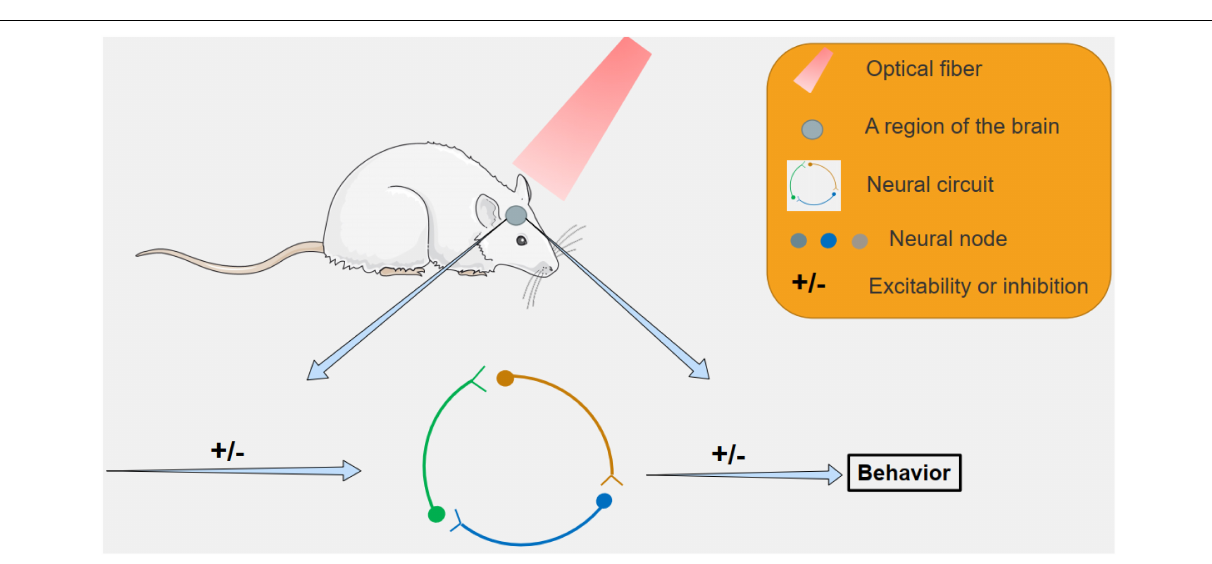
FIGURE 2 | The study of neural circuits by optogenetic methods. By targeting specific areas with light, specific neural circuits can be inhibited or activated, leading to behavioral changes in mice, and related neural circuits can be